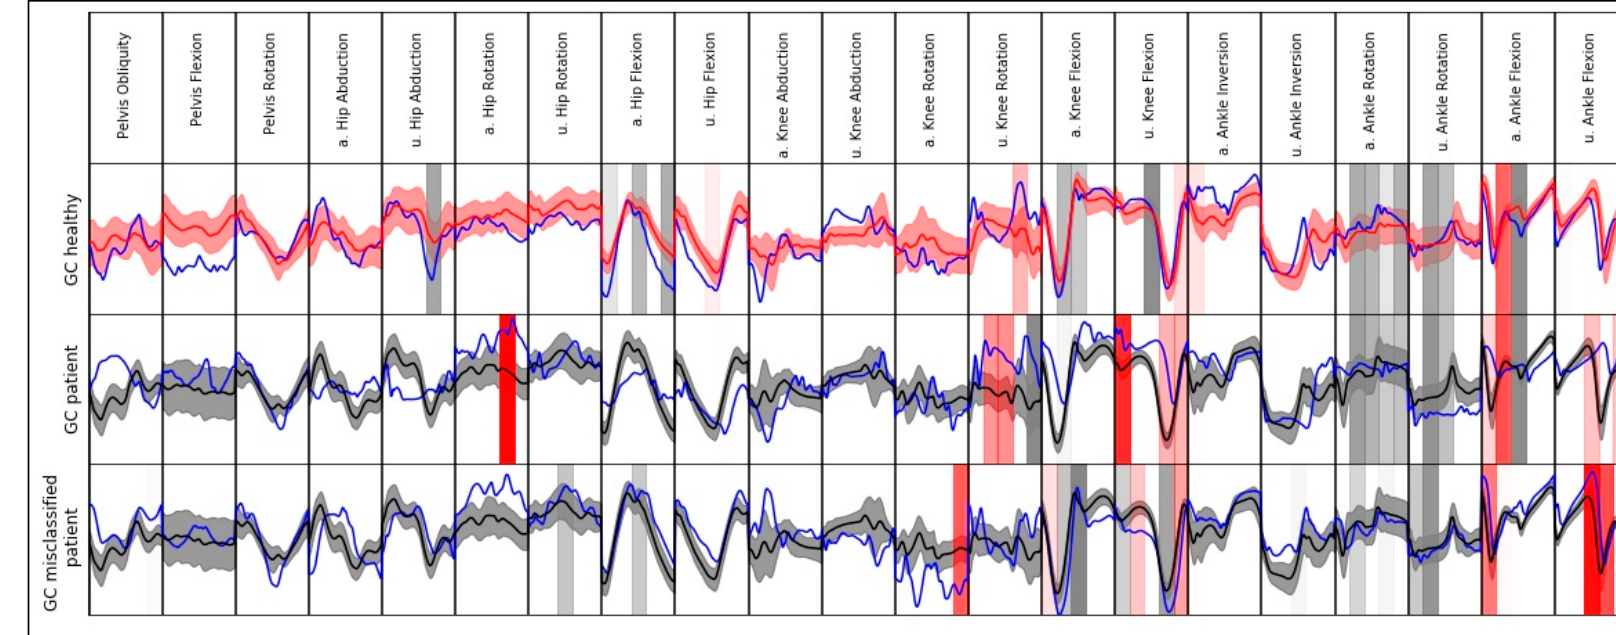
Figure 3. Exemplary local model interpretation for single gait cycle (GC) (instance) of a patient with THA, a healthy subject, and a GC of a patient classified as healthy (blue lines). The instances are plotted against the mean value and standard deviation of the other class (black = healthy, red = patient). For better visualization, the top 20 slices with the highest absolute effect are displayed for each instance (grey vertical span = effect towards class of healthy subjects, red vertical span = effect towards class of patients with THA). The color saturation indicates the effect size. For visualization reasons, data are separately scaled to a range from 0 to 1 for each variable. Abbreviations: a. = affected side; u. = unaffected side.